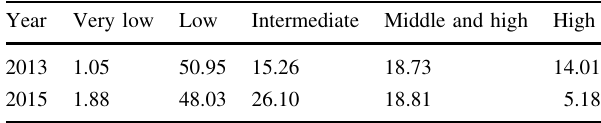
Table 2 The percentage of various types of vegetation to the total area